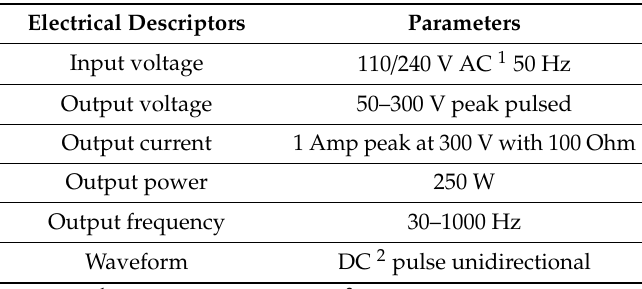
Table 1. Specifications of the prototype